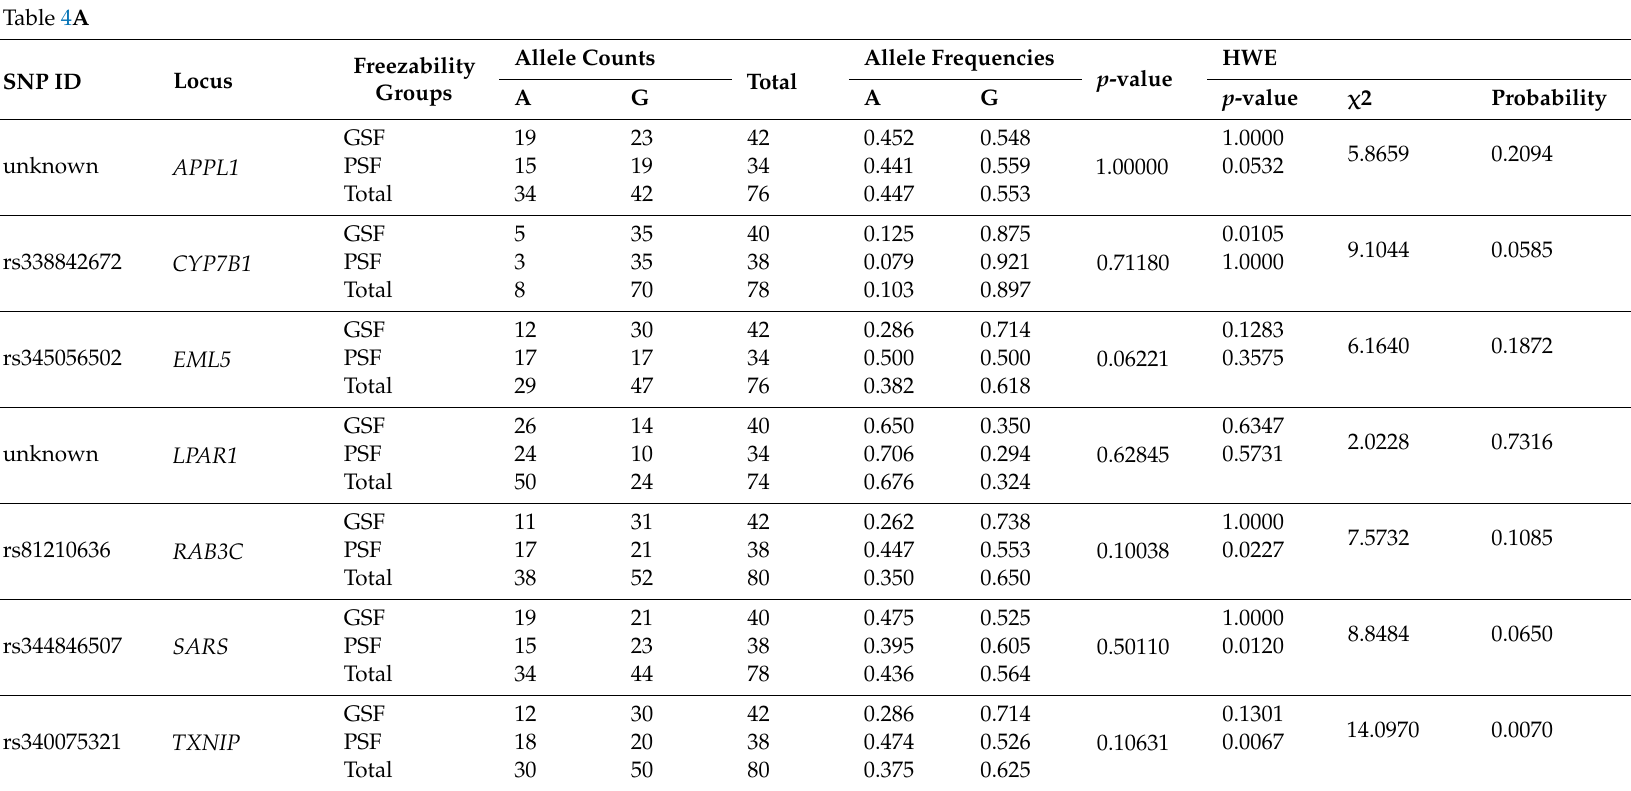
Table 4. Genic di ff erentiation, frequencies of single nucleotide polymorphism (SNP) alleles, and Hardy–Weinberg equilibrium (HWE) with respective p -value, chi-square ( χ 2), and probability. GSF—good semen freezability; PSF—poor semen